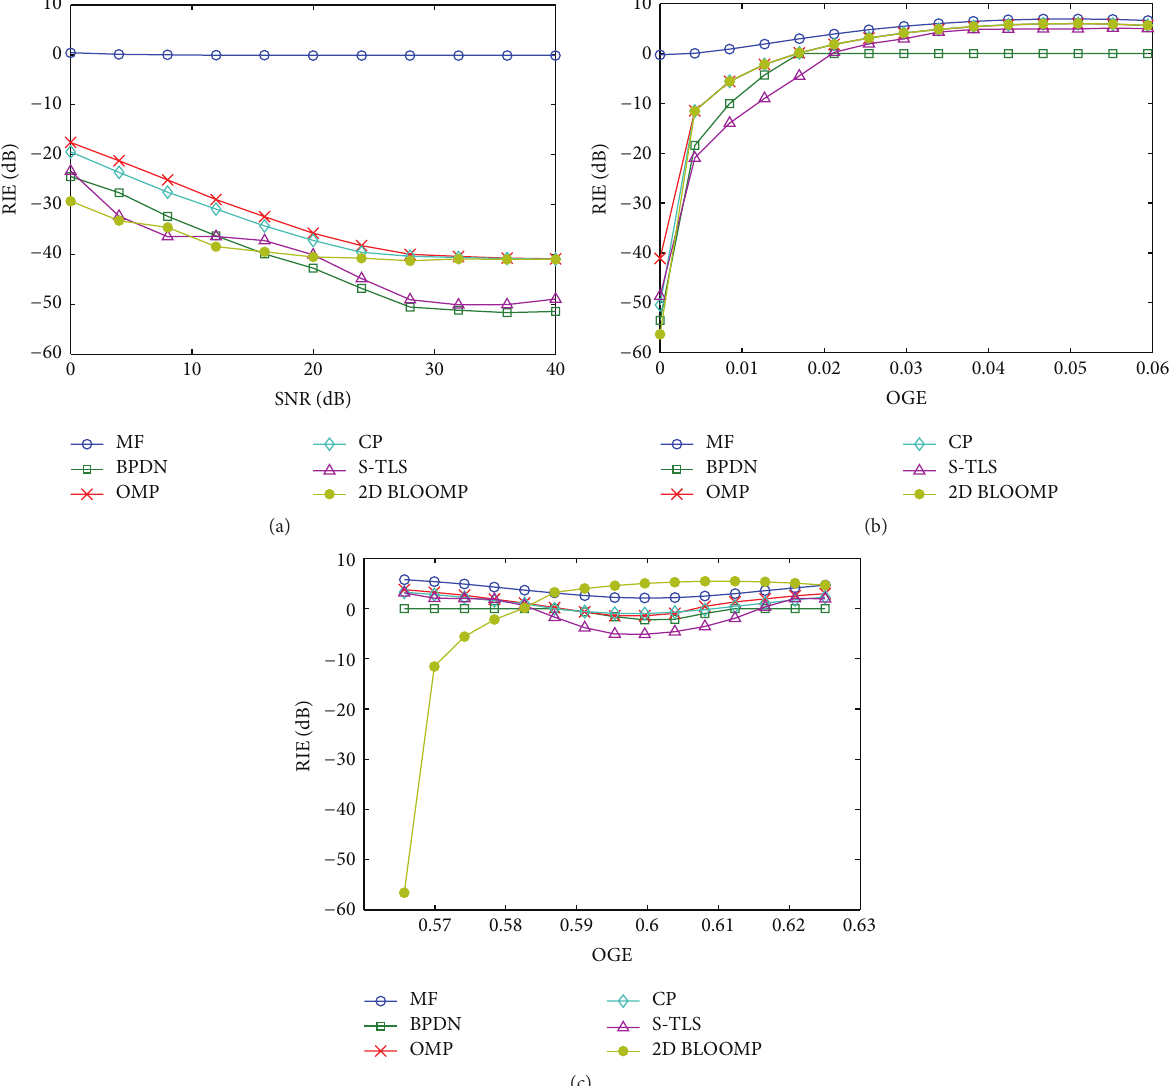
Figure 7: Results of performance experiments. (a) RIE versus SNR in the presence of off-grid. (b) RIE versus OGE ( 𝜁 = 0 ∼ 0.059). (c) RIE versus OGE ( 𝜁 = 0.566 ∼